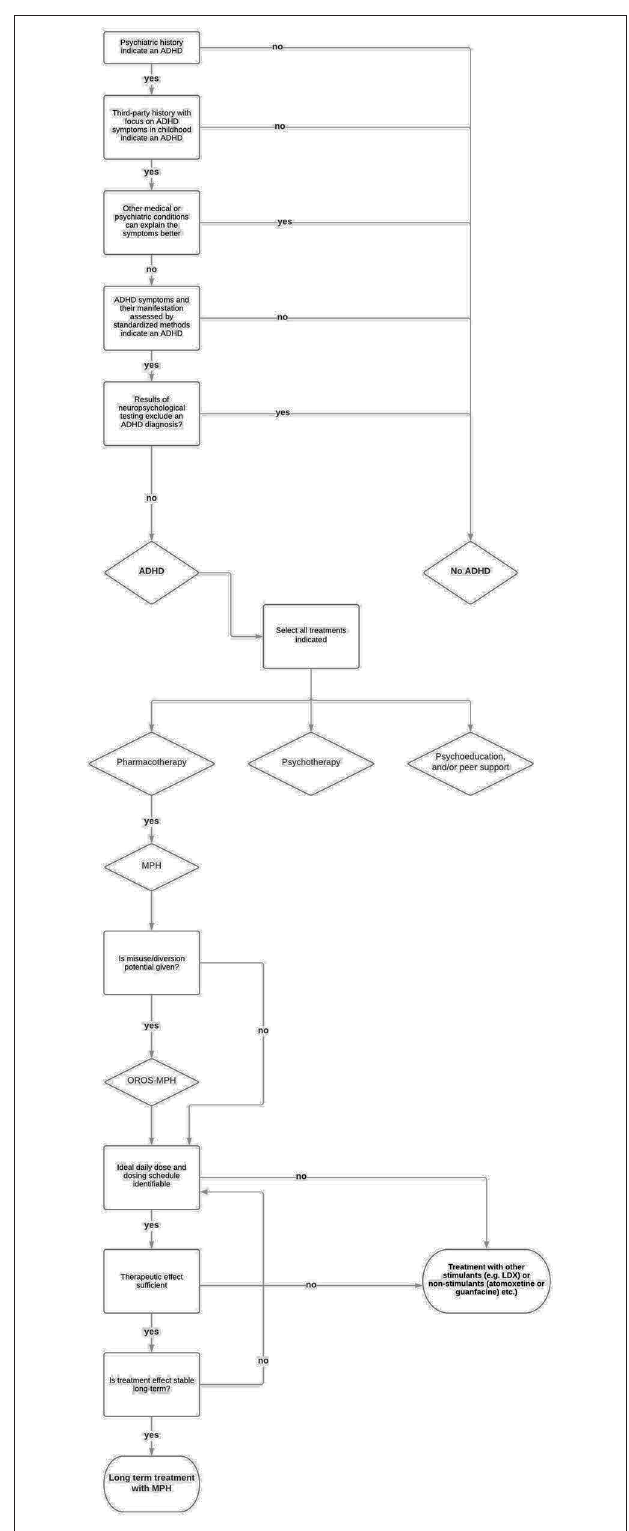
FIGURE 1 | Diagnosis and pharmacotherapy for adult ADHD in patients with